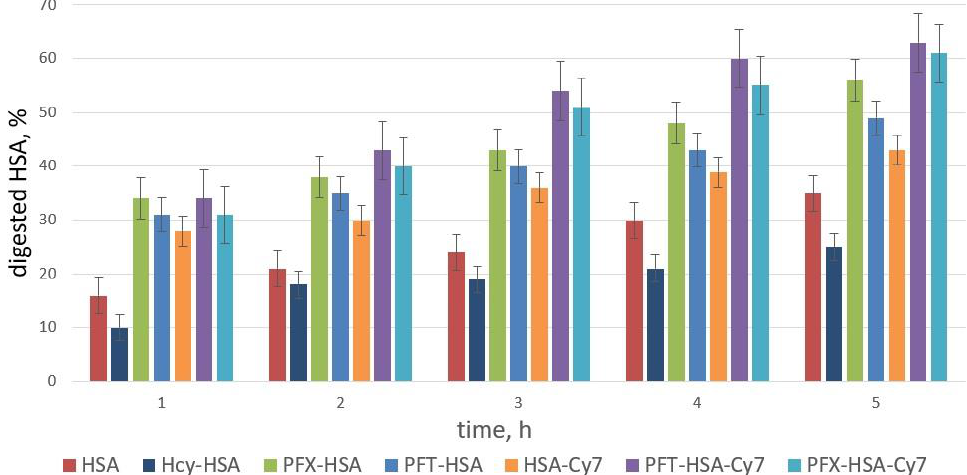
Figure 11. Susceptibility of HSA conjugates to tryptic proteolysis (enzyme/substrate ratio of 1:100). Samples were analyzed by SDS-PAGE. Albumin bands were visualized by Coomassie blue staining. Quantitative data were obtained by digitizing the gel (SDS-PAGE) using GelPro Analyzer software (Media Cybernetics). The bands in the gel lower than 66.5 kDa (HSA monomer MW) were marked as digested albumin (Figure S8).